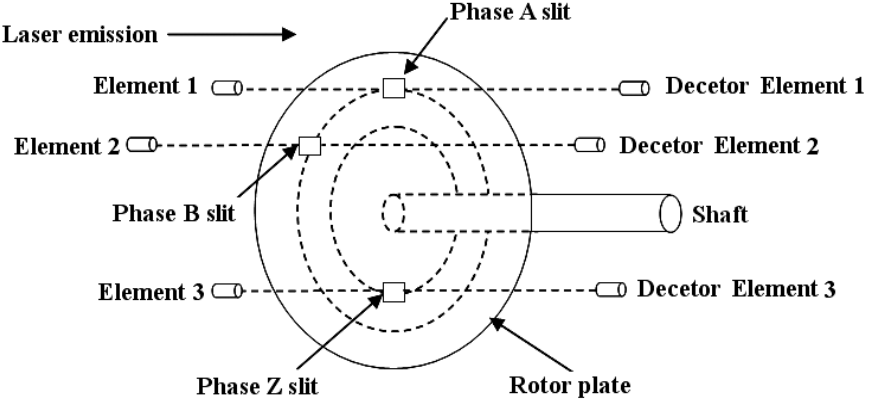
Figure 3. Working principle of the rotary